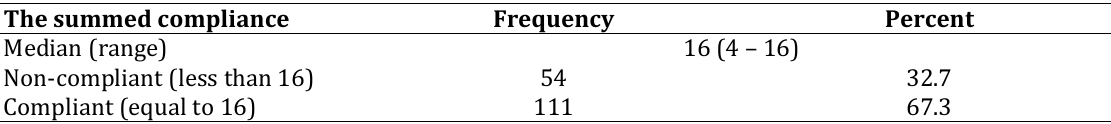
Table III. Total compliance score among